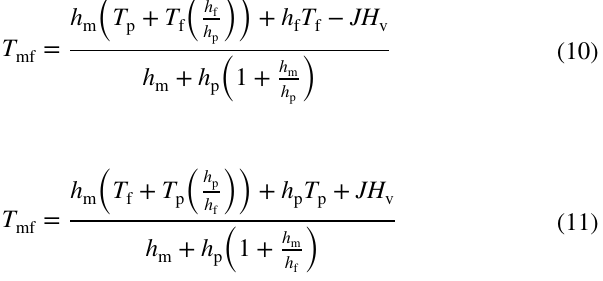
Fig. 2 Temperature concentration and vapour pressure profiles in DCMD. (Adapted from Tomaszewska et al.